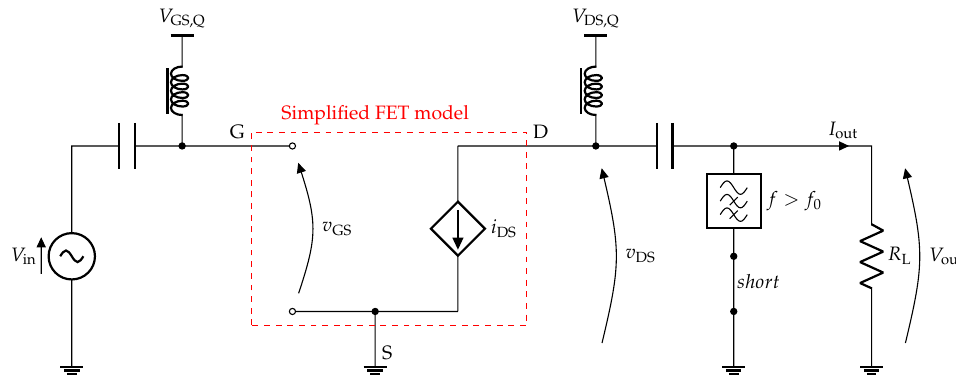
Figure 7. Tuned-load power amplifier: one or more parallel shunt resonators allow only the funda- mental component of the output voltage to flow into the resistive load R L